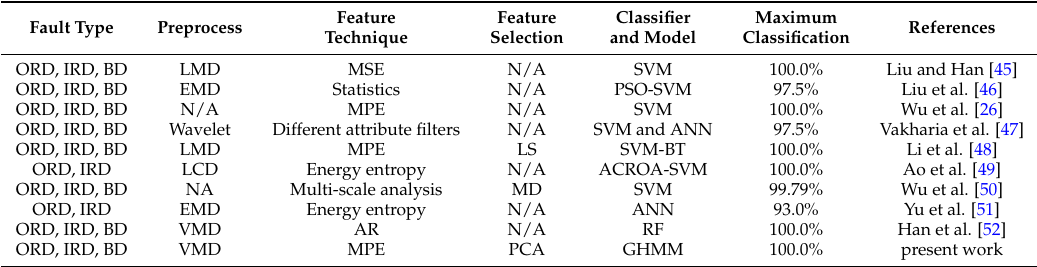
Table 9. Comparative studies for recognizing and classifying fault types of defect bearings.